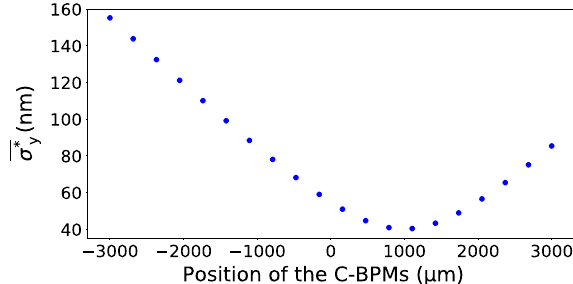
FIG. 15. Average vertical beam size at the IP σ (cid:1) y vs the beam intensity, for 100 machines, with (blue) and without (red) application of the wakefield knobs at 1 . 0 × 10 10 e − . The error bars represent the standard error for 100 machines and 200 pulses per machine. The lines show fits of Eq. (1).